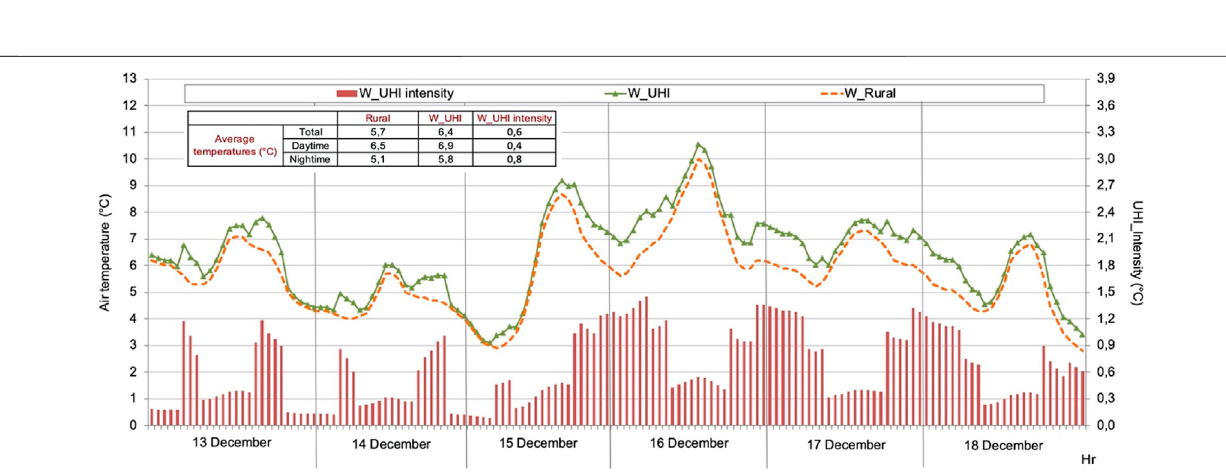
FIGURE 8 | Outdoor temperatures of rural and urban weather on 6 days in December and corresponding UHI intensities. Their average values in the three daily periods are also given.